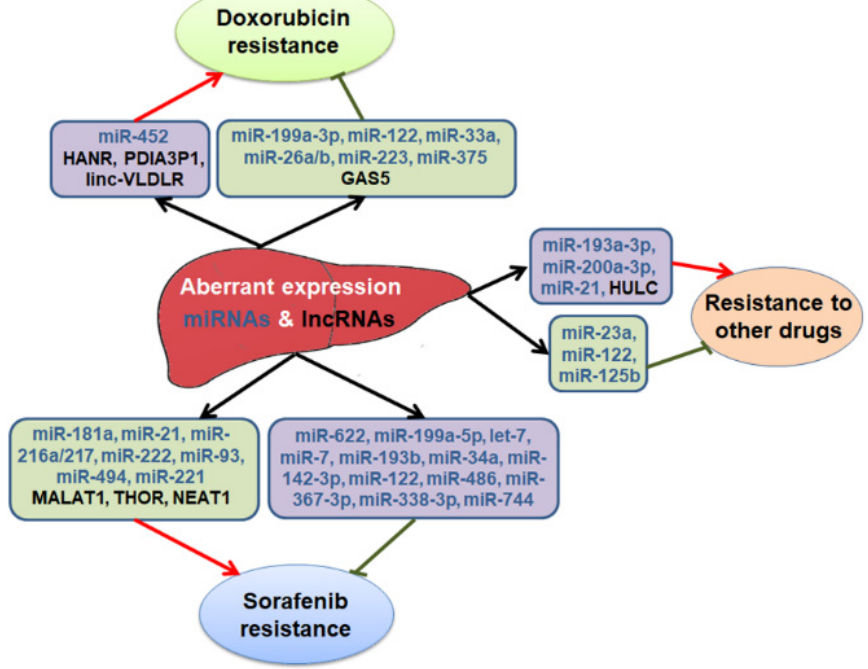
Figure 1. Non-coding RNAs contributing to therapy resistance in hepatocellular carcinoma HCC.